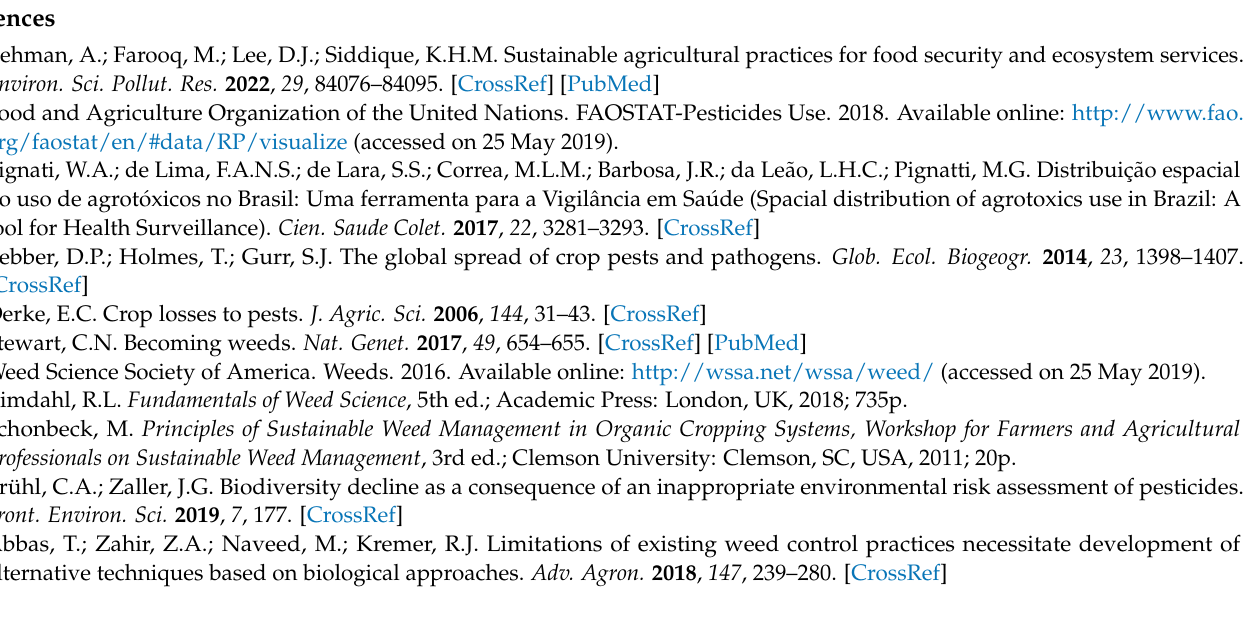
Figure S8. Substrate leaching bioassay. Germination rates of lettuce seeds in soil-like substrate with the previous application of the following treatments: distilled water (C-), aqueous extract at 4% (AE 4%) and aqueous extract at 10% (AE 10%), during 12 days of experiment. Bars show 95% confidence intervals (Wilson score interval). Treatments not sharing the same letter at the final sampling time differ in germinability ( p ≤ 0.05). Reference [46] is cited in the supplementary